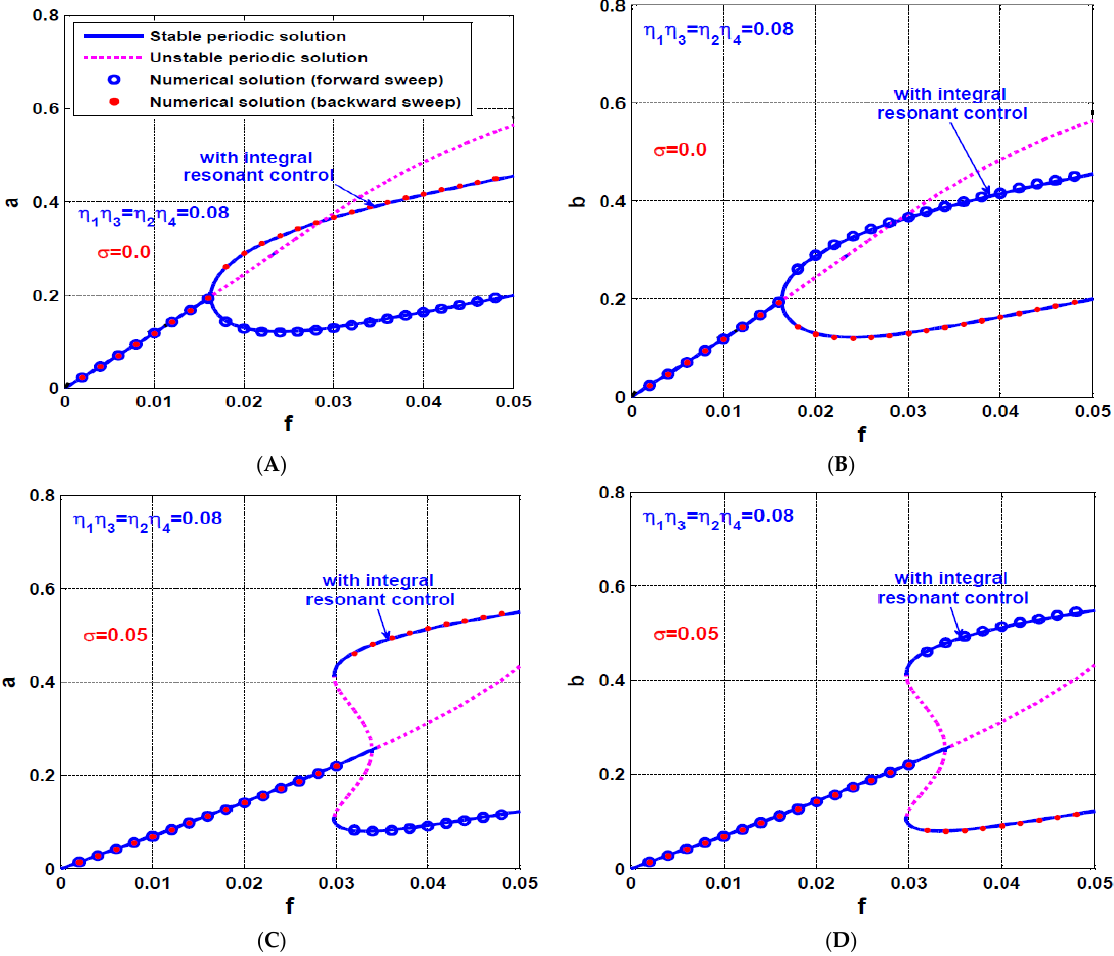
Figure 17. The rotor system 𝑓— response curve at two different values of the rotor spinning speed ( Ω = 𝜔 + 𝜎 , 𝜎 = 0.0,0.05 ) when activating both the U-IRC and V-IRC (i.e., (i.e.,𝜂 1 𝜂 3 = 𝜂 2 𝜂 4 = ( Ω = ω + σ , σ = 0.0, 0.05) when activating both the U-IRC and V-IRC ( i.e., η 1 η 3 = η 2 η 4 = 0.08): 0.08 ): ( A , B ) the system oscillation amplitudes a and b when 𝜎 = 0.0 , and ( C , D ) the system oscilla- ( A , B ) the system oscillation amplitudes a and b when σ = 0.0, and ( C , D ) the system oscillation tion amplitudes a and b when 𝜎 = 0.05 . amplitudes a and b when σ =